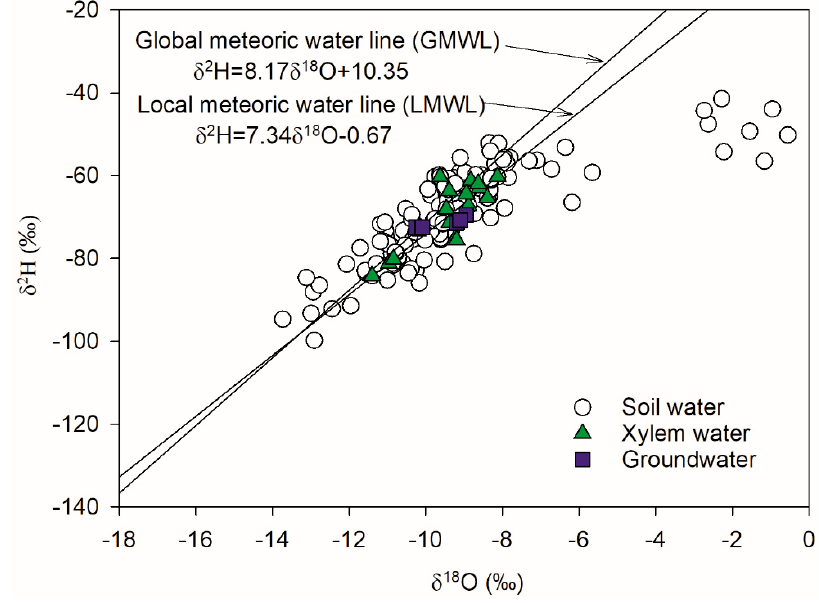
Figure 3. Relationships between δ 2 H and δ 18 O for the xylem water, soil water, and groundwater during the measurement period.